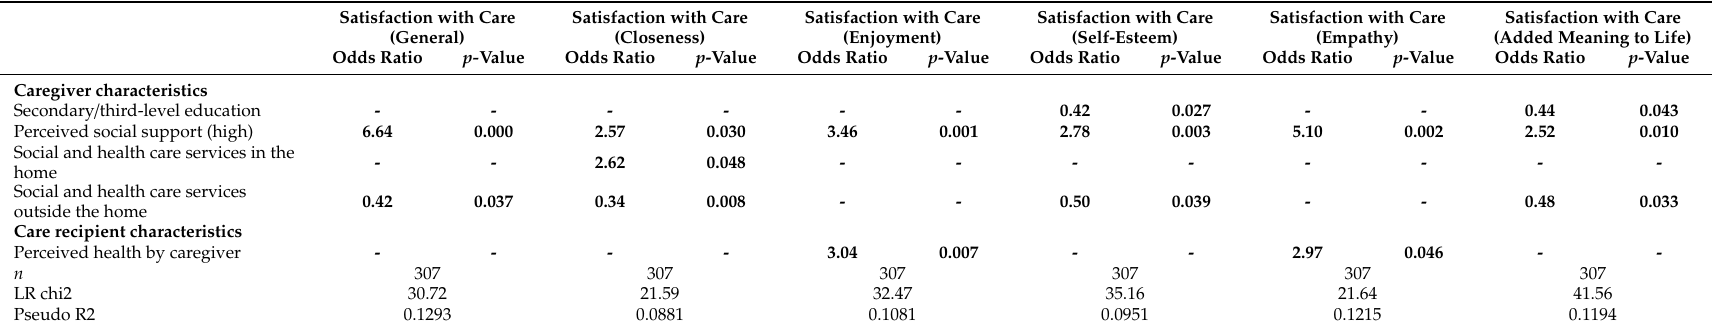
Table 6. Variables associated with informal caregiver satisfaction with caregiving role: multivariate analysis for women 1 . Satisfaction with Care Satisfaction with Care Satisfaction with Care Satisfaction with Care Satisfaction with Care Satisfaction with Care (General) (Closeness) (Enjoyment) (Self-Esteem) (Empathy) (Added Meaning to